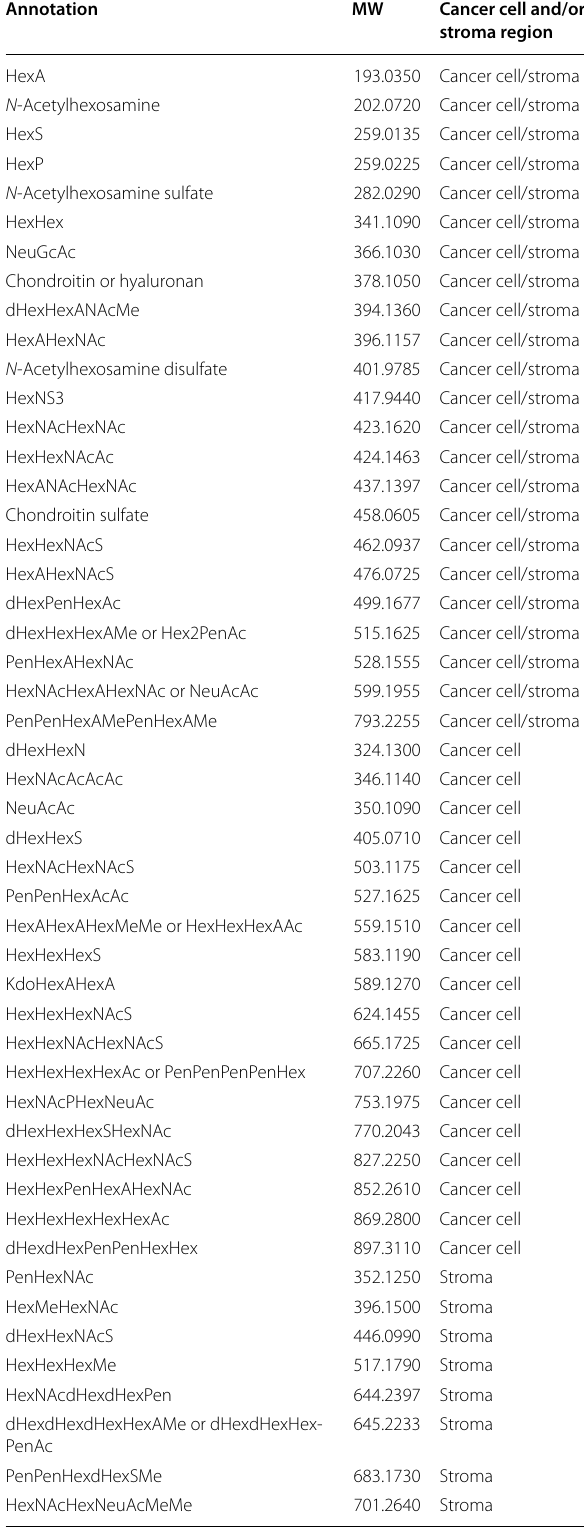
Table 2 List of annotated glycan